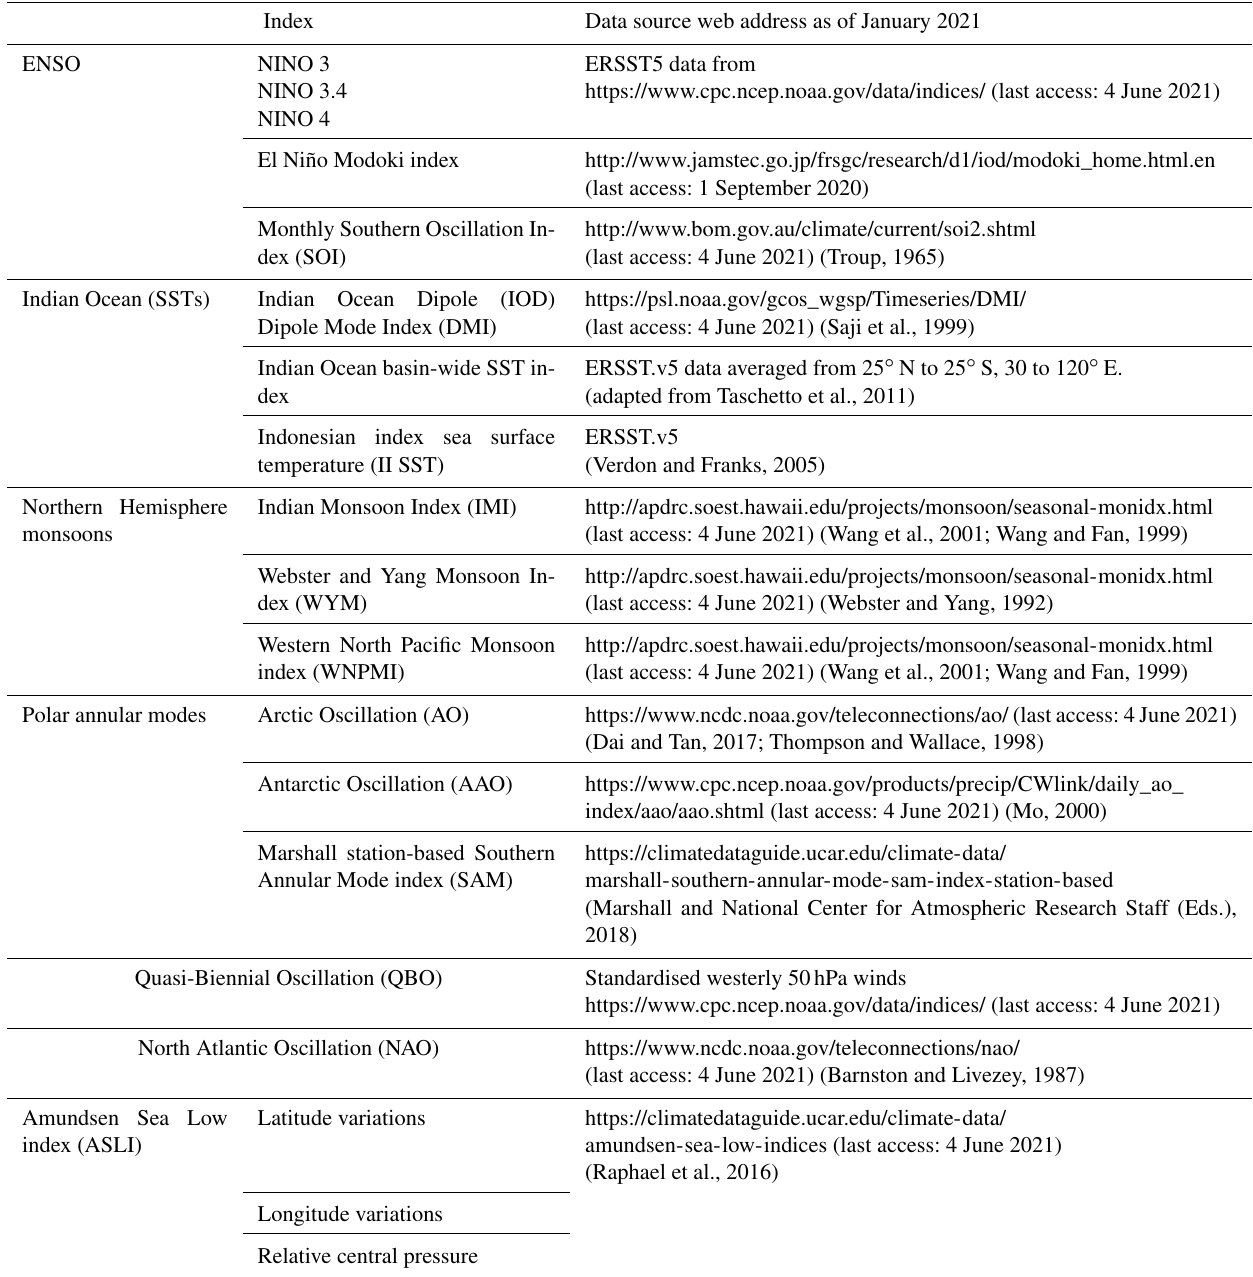
Table 2. Data sources for major climate drivers used in this study. The web links listed in the table were valid as of the date this work was